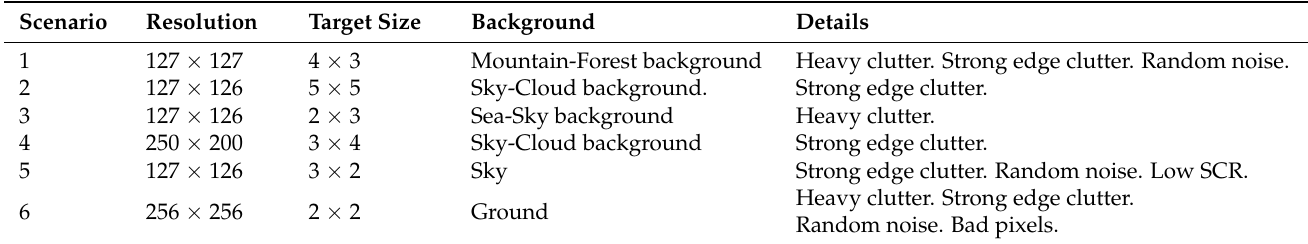
Figure 7. Samples of the six real IR complex scenarios. ( a – f ) Scenario 1–Scenario 6. Table 2. Information of the six scenarios.